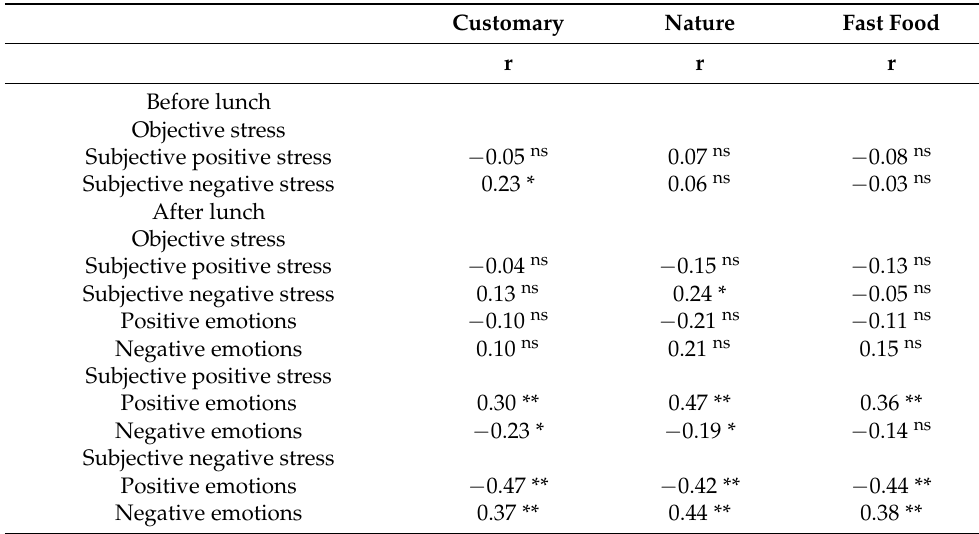
Table 3. Spearman’s rank correlations between objective stress, subjective stress and emotions evoked by the ambiences. Data from the subgroup of participants ( n = 32). ** p ≤ 0.01, * p ≤ 0.1, ns non-significant correlation.